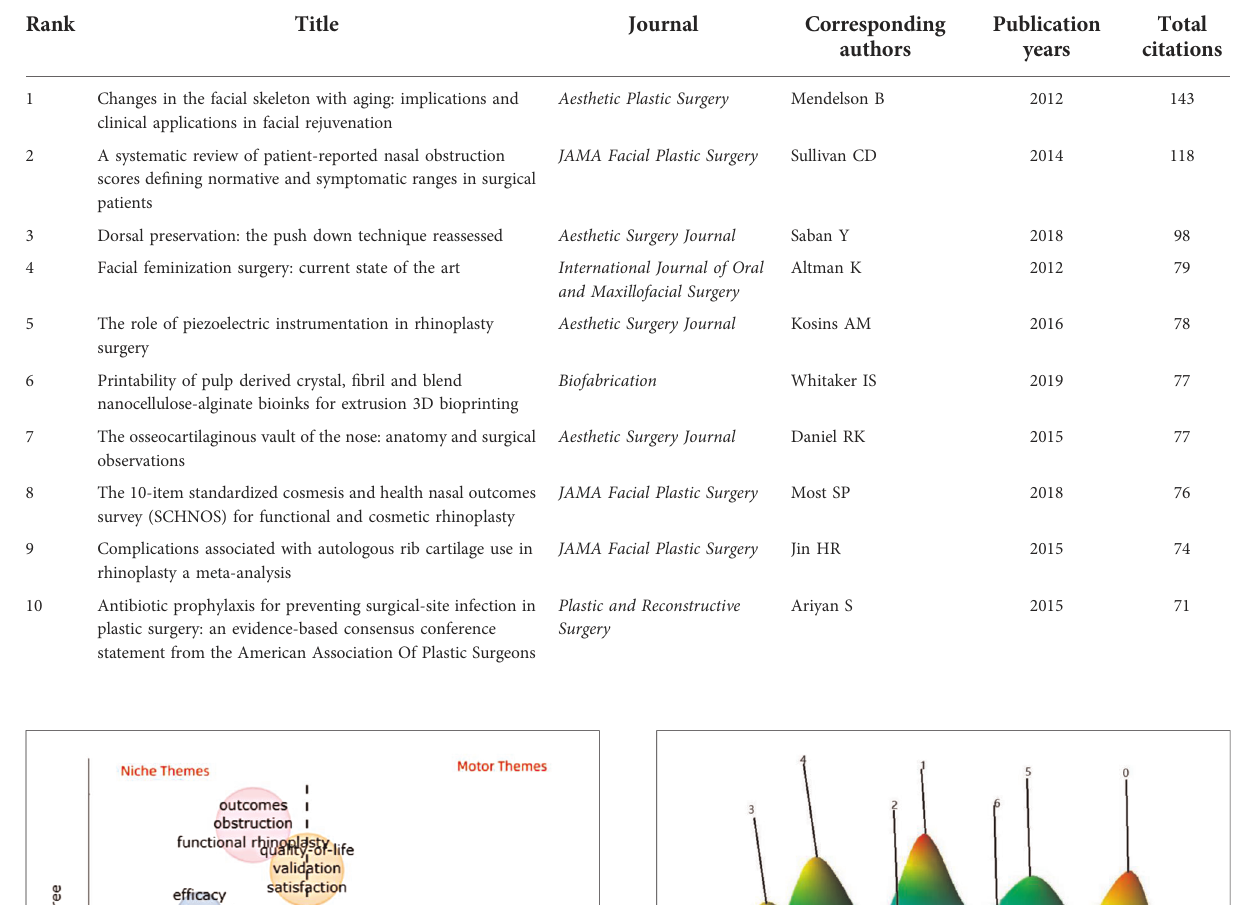
TABLE 4 The top 10 high-cited papers in rhinoplasty research from 2012 to 2021.